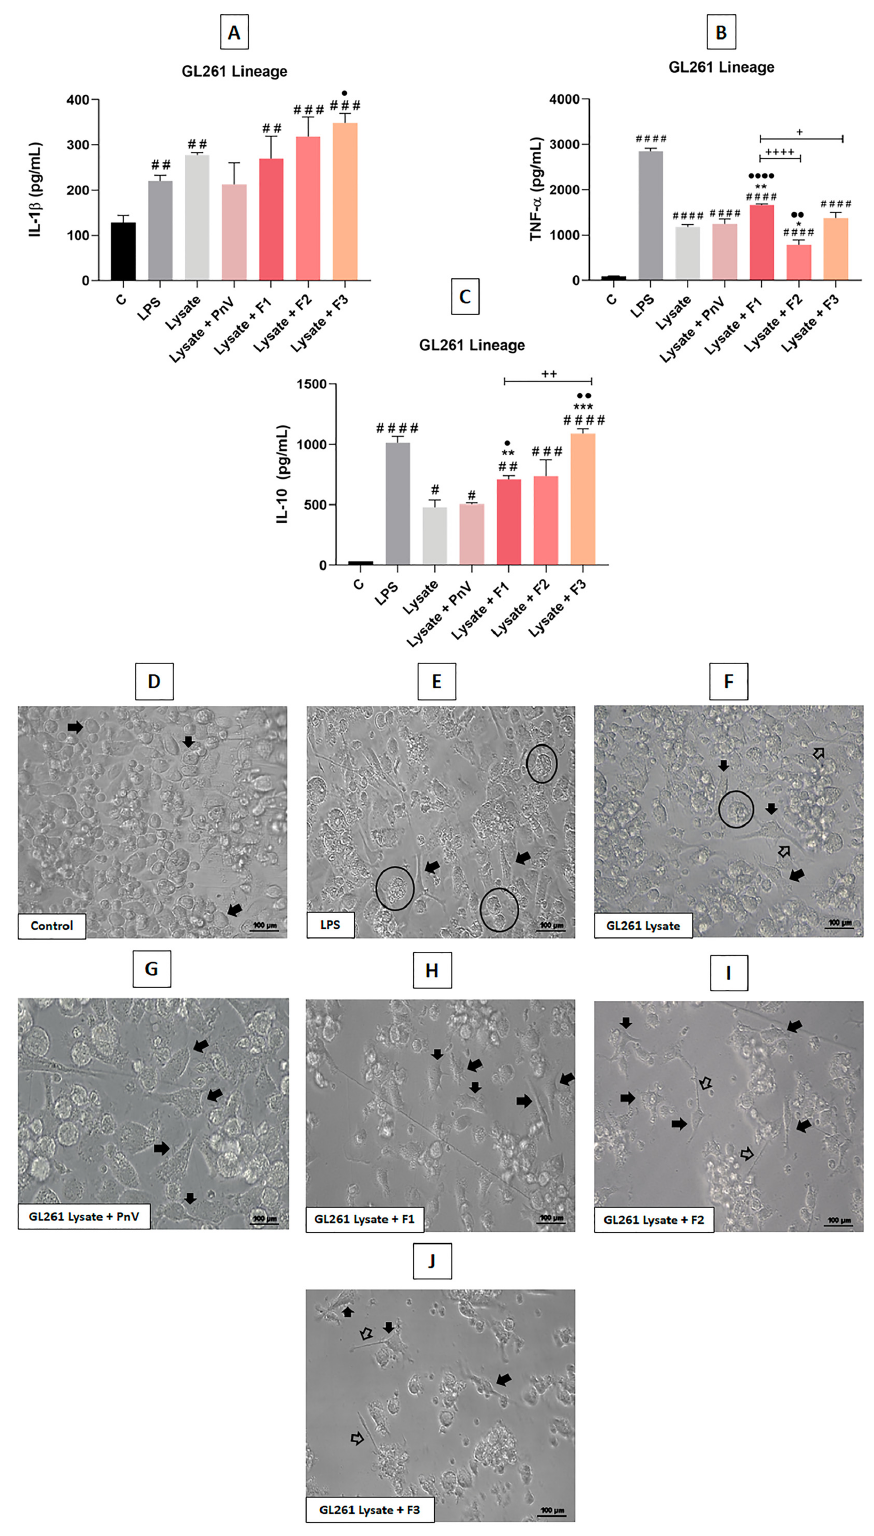
Figure 6. Cytokines release and morphology of DCs stimulated with glioblastoma cells (GL261) lysate. Graphs ( A – C ) show production of pro-(IL-1 β , TNF- α ) and anti-inflammatory (IL-10)